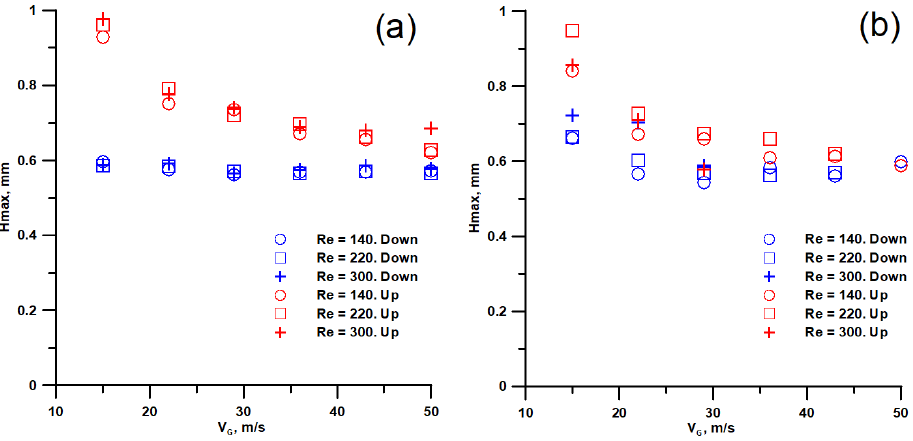
Figure 3. Maximum film thickness near the inlet versus gas velocity: ( a ) Water; ( b ) WGS2.